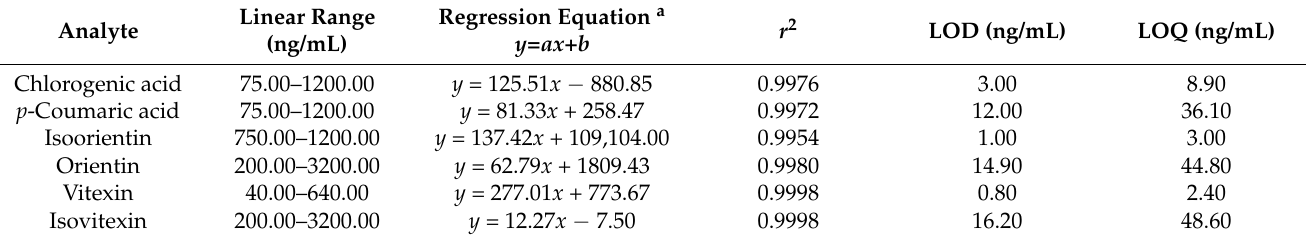
Table 6. Linear range, regression equation, r 2 , LOD, and LOQ for simultaneous analysis of marker analytes in P. pubescens leaves using LC–MS/MS MRM